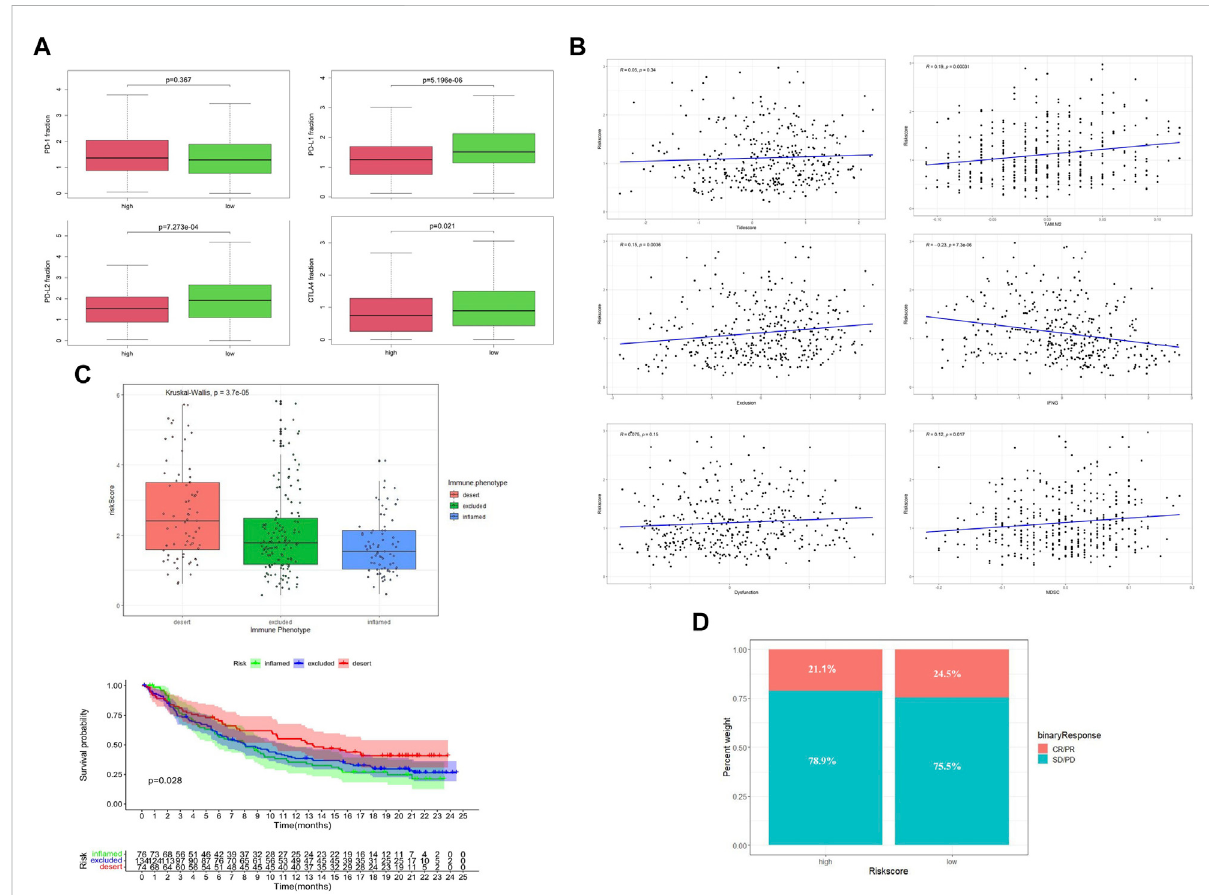
FIGURE 6 Evaluation of immune status between low-risk and high-risk groups. (A) Expression level of immune checkpoint genes. (B) Tumor immune dysfunction and exclusion scores in the high- and low-risk groups. (C) Relationship between risk score and the immune phenotype in